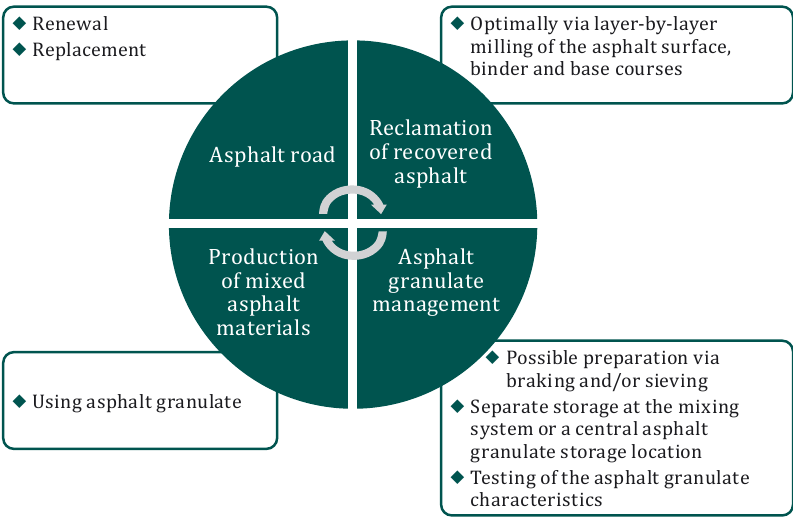
◆ Using asphalt granulate Figure 1. Principles of the circular economy for asphalt pavement renewal used in the trial stage of P2 road